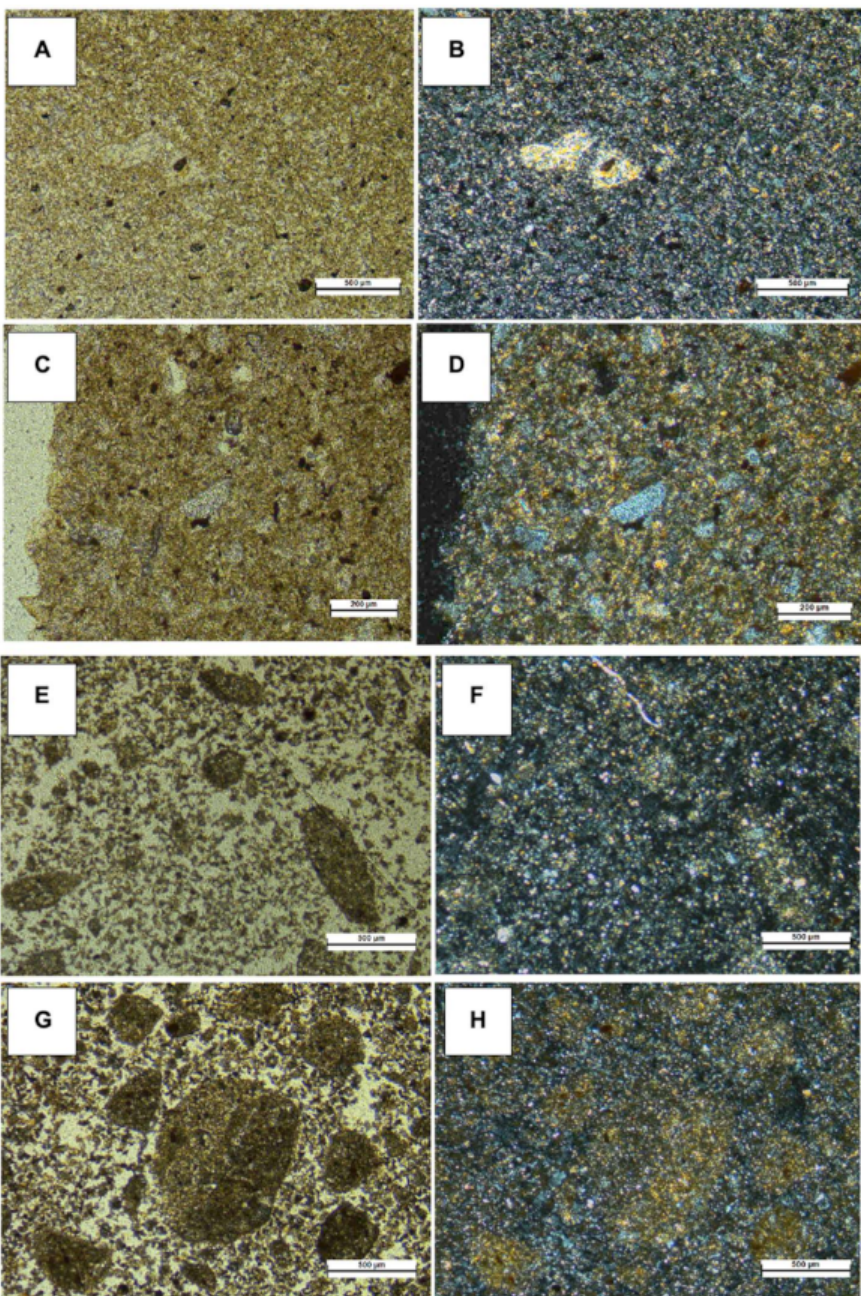
Figure 3. Petrography of the TS10 sample: crushed raw material ( A–D ) and crushed treated material ( E–H ). Scale bars: 500 µ